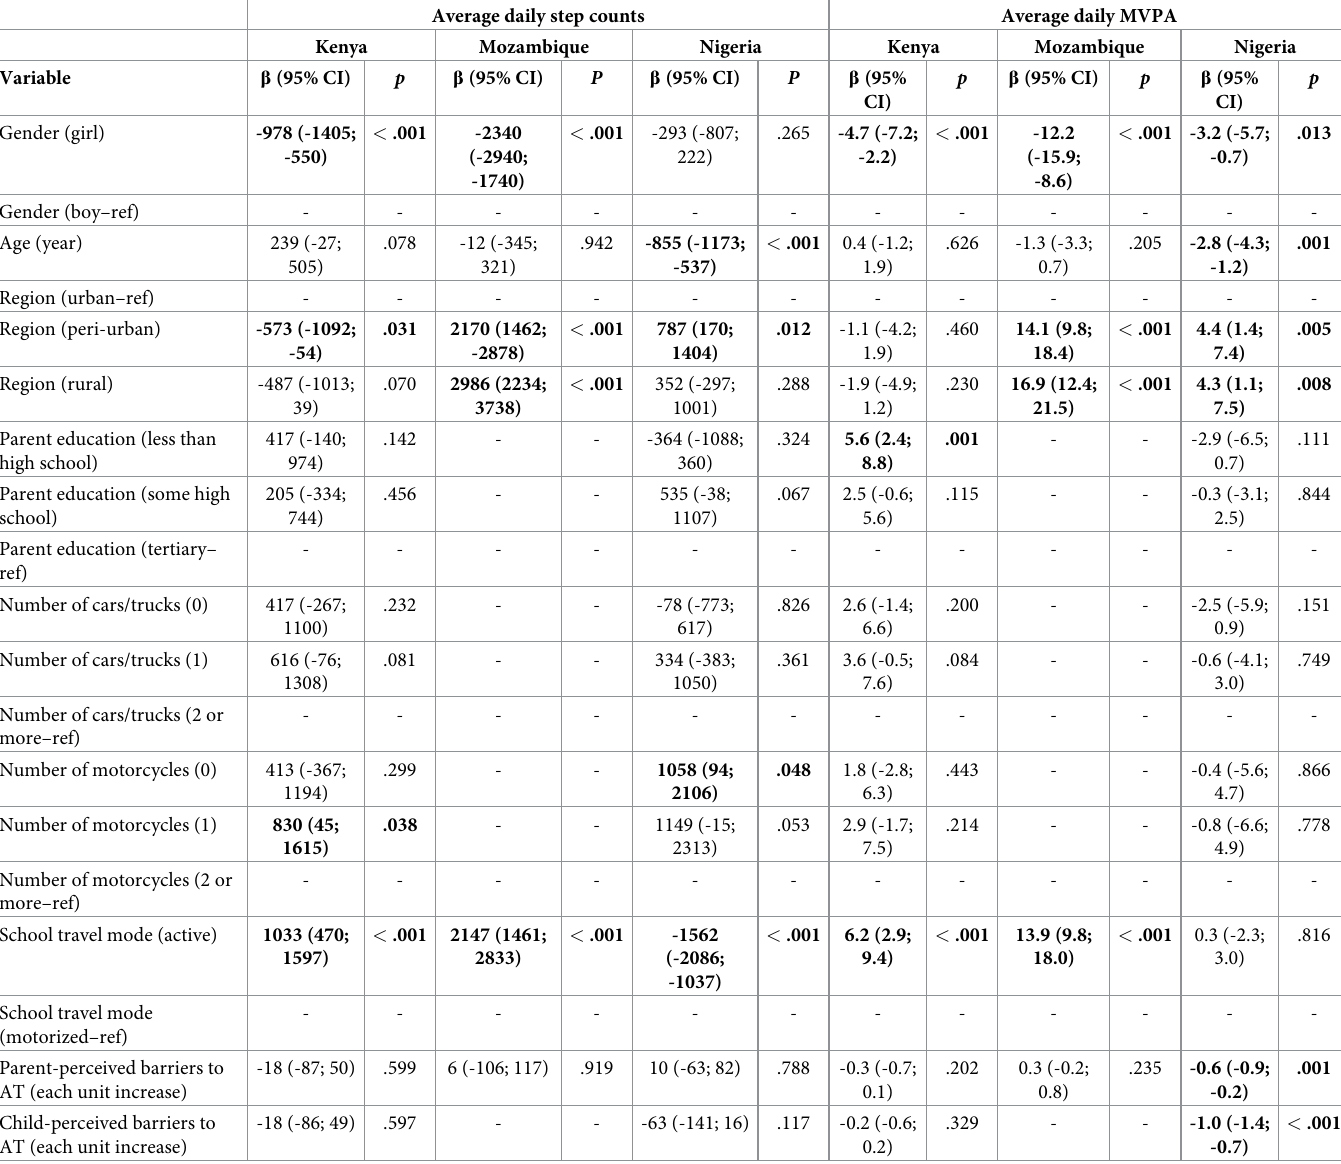
Table 5. Correlates of average daily step counts and average daily MVPA stratified by country in bivariate